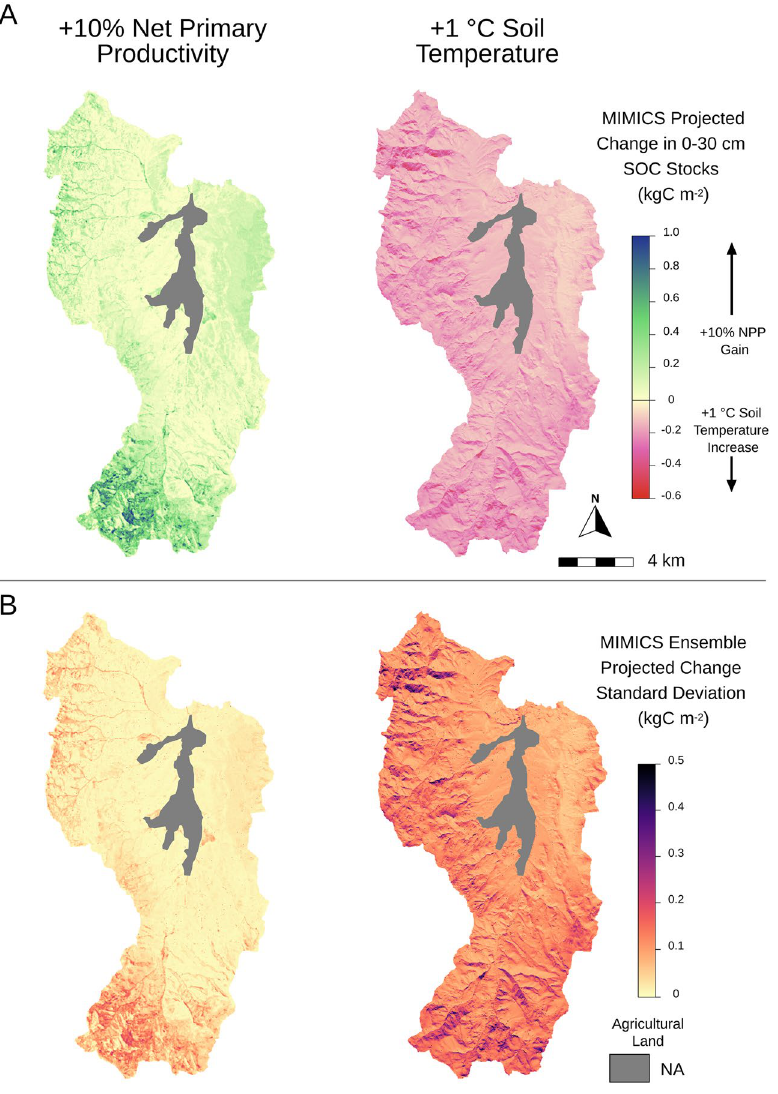
Figure 7. MIMICS projected ( A ) total change and ( B ) parametric uncertainty for change in 0–30 cm soil carbon stocks from 10% increase in net primary productivity (NPP) or 1 °C increase in mean annual soil temperature. (Generated by free software R, https:// www.R- proje ct.